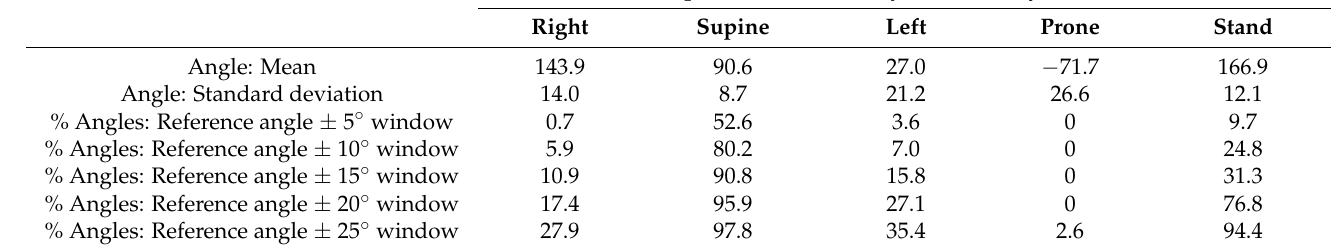
% Angles: Reference angle ± 25 ◦